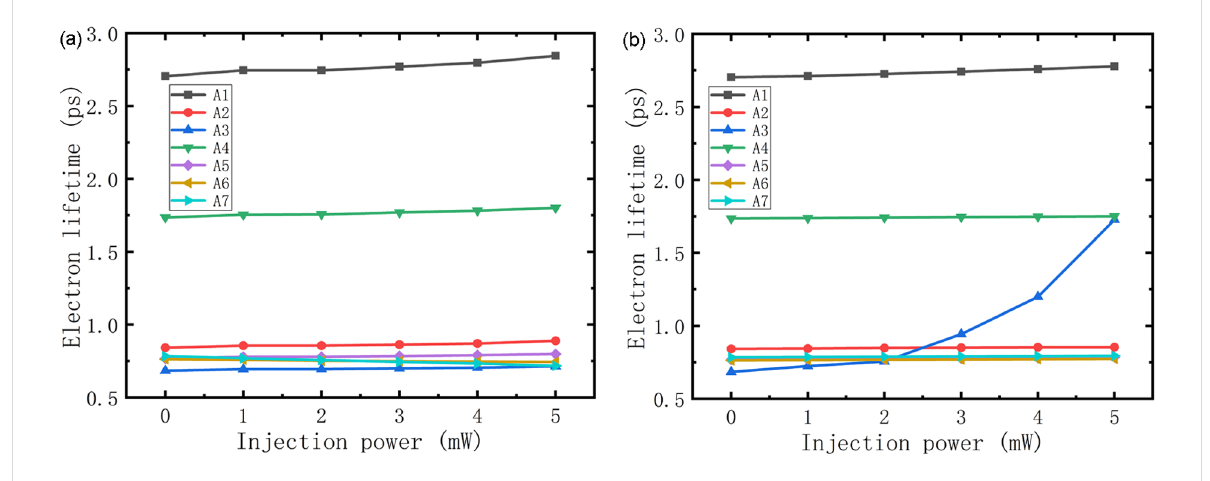
Figure 4: Electron lifetime of each subband using optical injection at wavelengths of 1550 nm (a) and 820 nm (b).